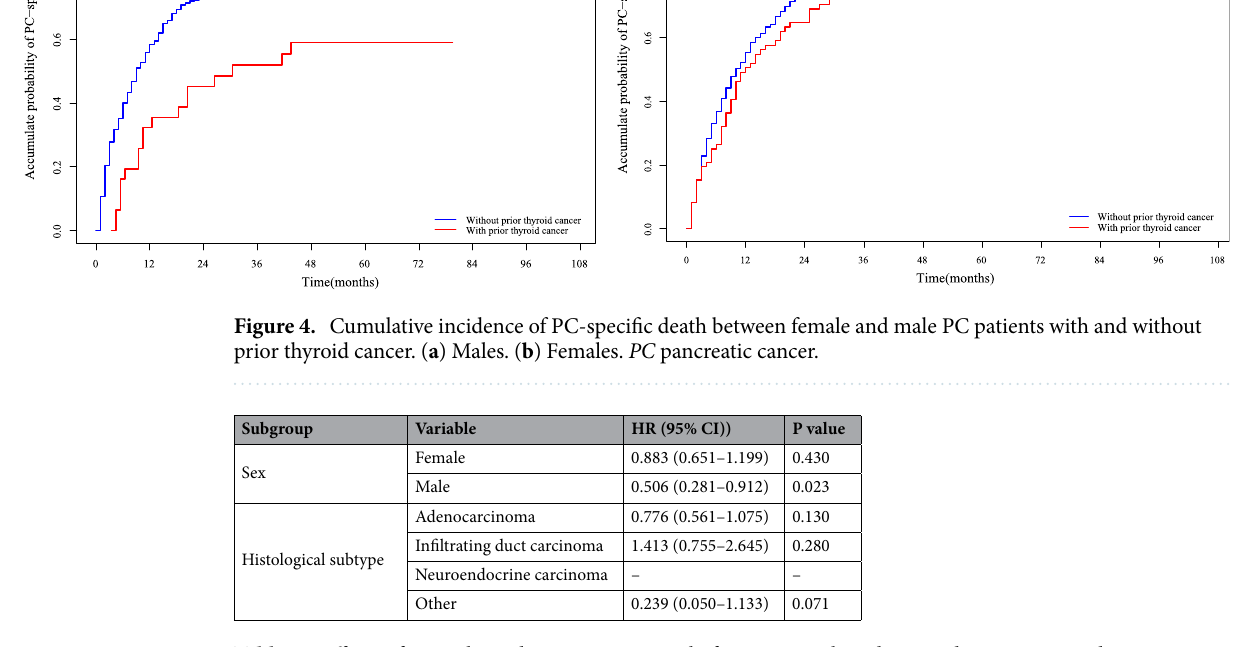
Table 4. Effects of prior thyroid cancer on survival of PC patients based on gender grouping and tumor histological subtype grouping. HR hazard ratio, CI confidence interval.